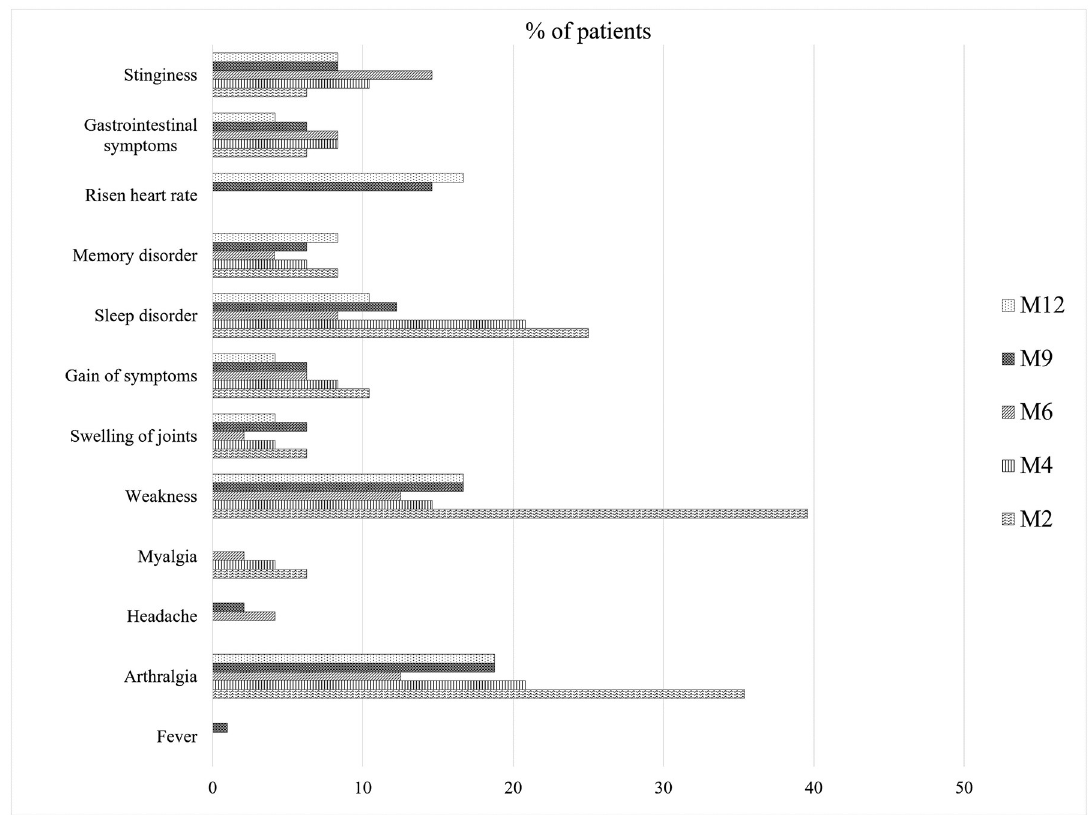
Fig 5. Persistence of chikungunya symptoms over time course in CHIKV positive